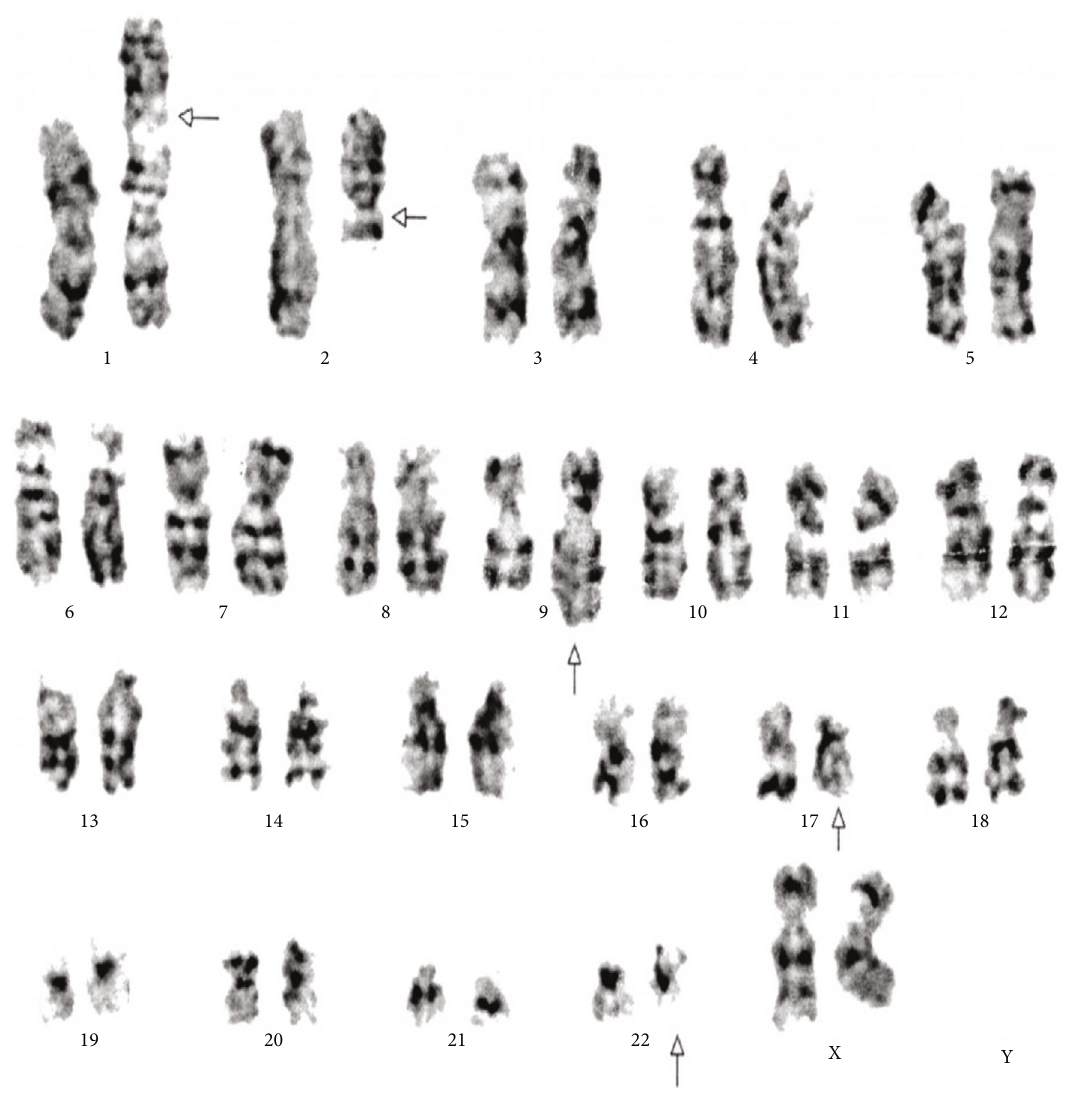
Figure 1: Cytogenetic analysis shows karyotype of fi ve-way complex translocation 46XX,t(1;2;2;17;9;22)(p36.3,q21;q11.2,q21,q34,q11.2)